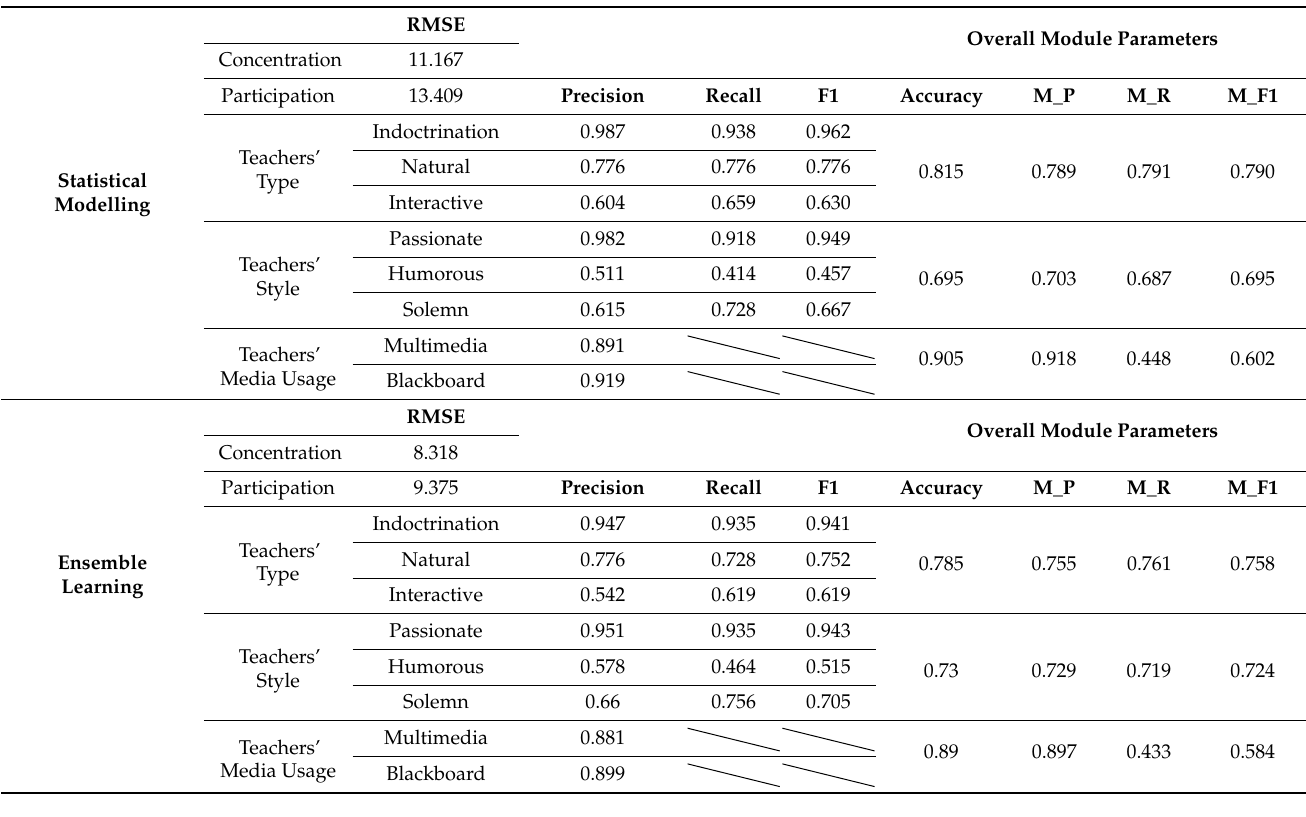
Table 11. The evaluation performance of all experiments.